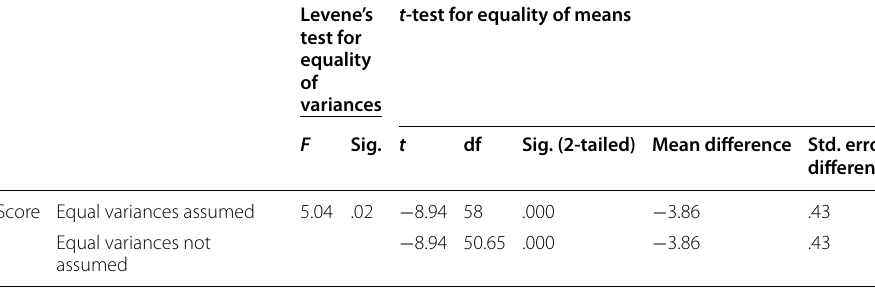
Table 9 Inferential statistics (fluency post‑test of both groups)